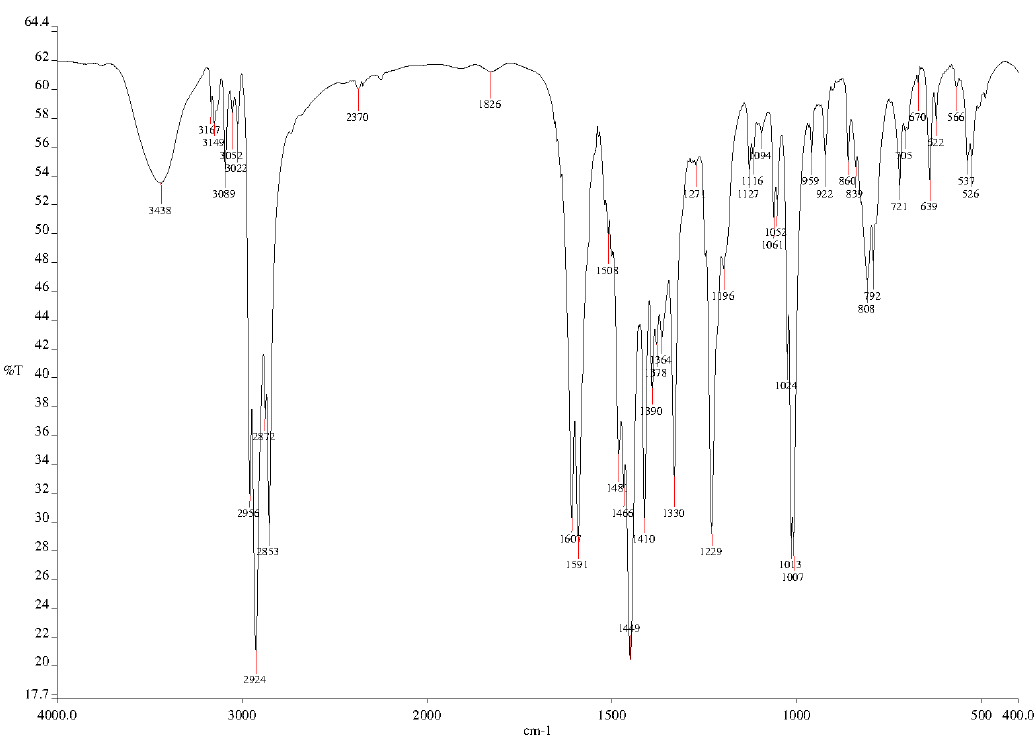
Figure 3. IR spectrum (KBr) ν (cm − 1 ).